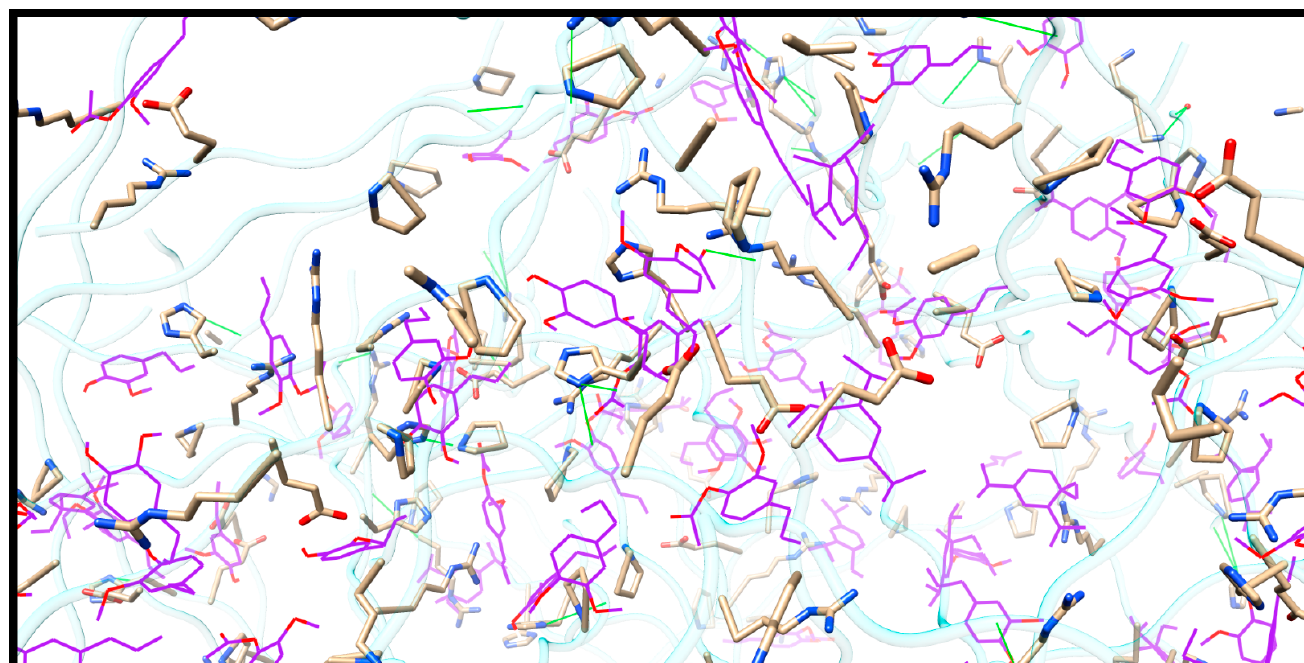
Figure 2. Enlarged view of the EO-impregnated biofilm, where the side chains of the amino acids that interact with the EO compounds are represented (color purple). The amino acid side chains are represented by sticks, while the EO compounds are represented on the wire. The green lines represent hydrogen bonds. Color coding to represent atoms: oxygen is colored red, and nitrogen, blue.